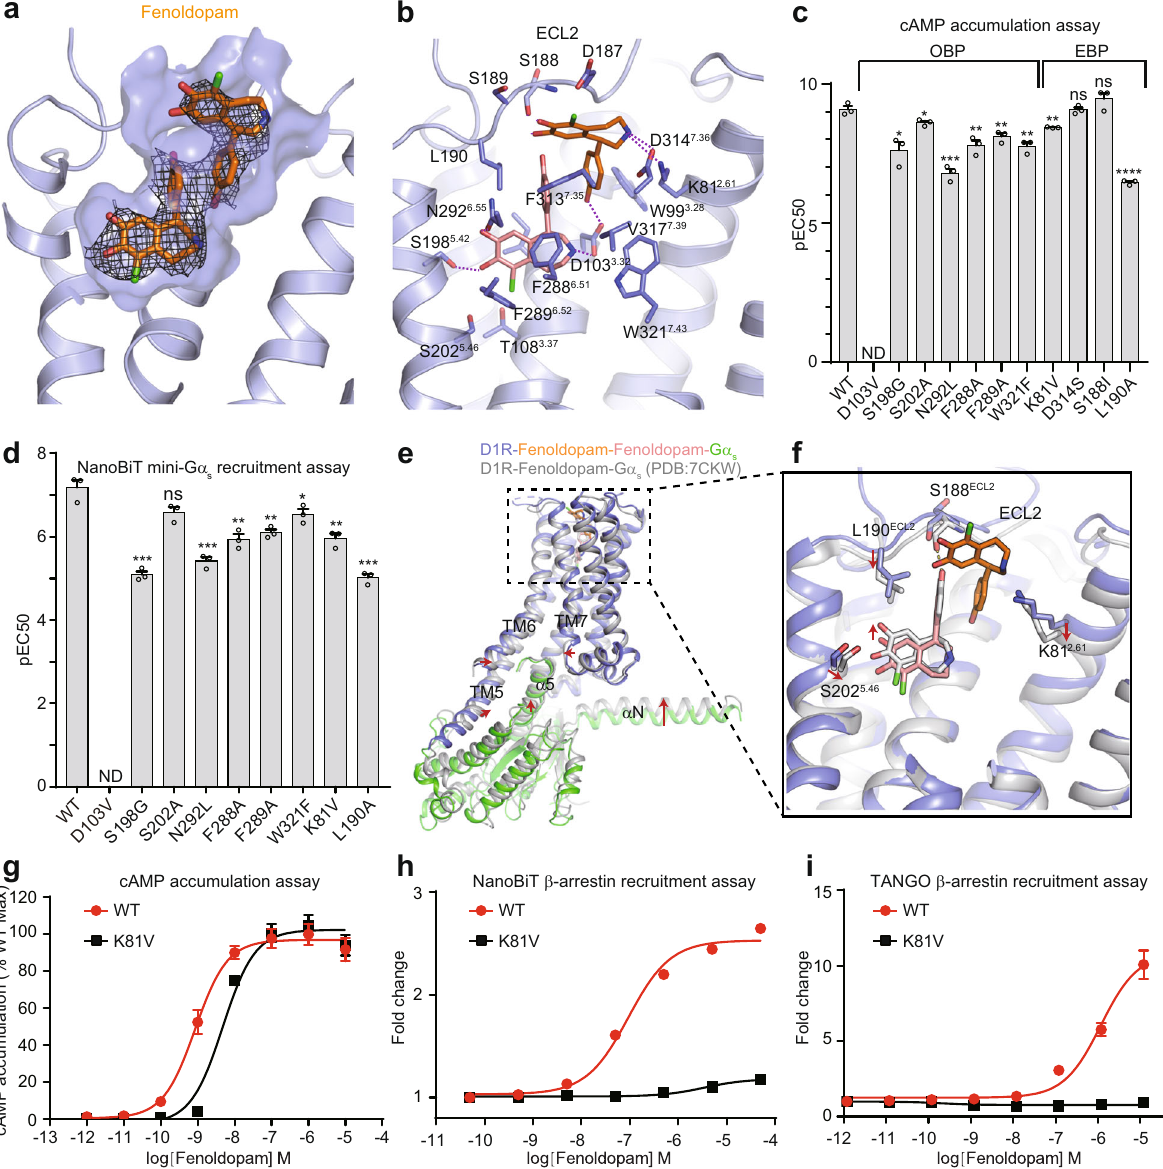
Fig. 2 Distinct binding mode of fenoldopam in D1R. a Surface view of the fenoldopam-binding pocket. EM density map for fenoldopam is shown. b Detailed interactions between the two fenoldopam molecules and the receptor. Dashed lines represent hydrogen bonds. c cAMP accumulation assay for D1R wild-type (WT) and mutants activated by fenoldopam. The assay was performed in HEK293 cells stably expressing the cAMP GloSensor. EC50 values are determined from three independent experiments. Data are presented as mean values ± SEM. Statistical signi fi cances of D1R mutants were obtained using two-tailed Student ’ s t test (* p < 0.05, ** p < 0.01, *** p < 0.001, **** p < 0.0001). ND not determined, ns no signi fi cant difference. The exact p values are as follows, S198G, * p = 0.0104; S202A, * p = 0.0265; N292L, *** p = 0.0004; F288A, ** p = 0.0042; F289A, ** p = 0.0048; W321F, ** p = 0.002; K81V, ** p = 0.0059; D314S, p = 0.9475; S188I, p = 0.2013; L190A, **** p = 0.00003. d NanoBiT mini-G α s recruitment assay for D1R WT and mutants. Data are presented as mean values ± SEM from three independent experiments. p values were obtained by two-tailed Student ’ s t test (* p < 0.05, ** p < 0.01, *** p < 0.001, **** p < 0.0001). The exact p values are as follows, S198G, *** p = 0.0005; S202A, p = 0.0539; N292L, *** p = 0.001; F288A, ** p = 0.0048; F289A, ** p = 0.0052; W321F, * p = 0.042; K81V, ** p = 0.0047; L190A, *** p = 0.0004. e Structural comparison of the fenoldopam-bound D1R complex between this study and previous studies (PDB ID: 7CKW) with the receptor aligned. f Close-up views of the conformational differences of the fenoldopam- binding pocket between different studies. Concentration-response curve for D1R WT and the K81V mutant activated by fenoldopam measured using cAMP accumulation assay ( g ), NanoBiT ( h ) and TANGO ( i ) β -arrestin recruitment assay. All data represent mean ± SEM from three independent experiments. Response of the cAMP assay is expressed as percentage of maximal response of WT. Source data are provided as a Source Date fi EBP such as F313 7.53 (Supplementary Fig. 3b). The upward generates a narrower space, which cannot accommodate the second movement of fenoldopam in the OBP pulls down the ECL2 through fenoldopam in the EBP, accounting for its absence in the published hydrogen bond interaction between the hydroxyl group of phenol structure. These conformational differences of the ligand-binding and the main chain carbonyl group of S188 on ECL2 (Fig. 2f). The pocket and intracellular pocket of the receptor may arise from the resulting closer distance between ECL2 and fenoldopam in the OBP different versions of G α s in the complexes (mini-G s versus the full-